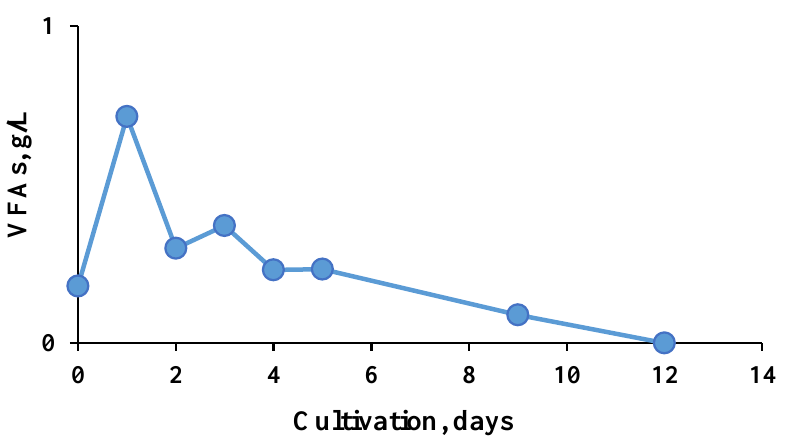
Figure 5 . Dynamics of the total VFA concentration during the methanogenic process. The consortia of microorganisms during biodegradation produced the following cocktail of VFA (Figures 6 and 7).